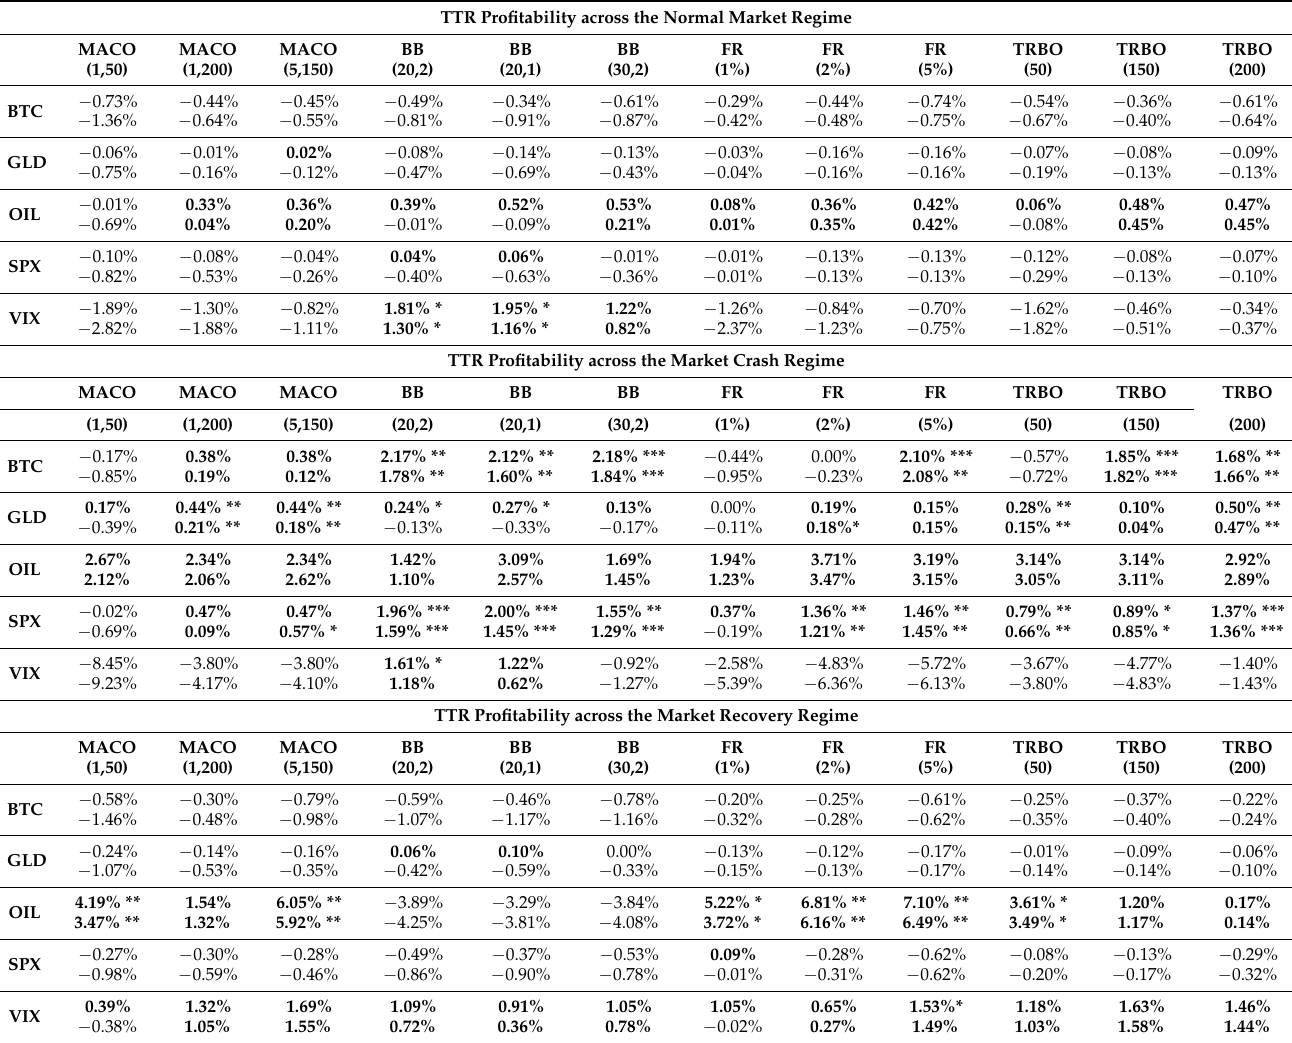
Table A3. TTR Profitability across COVID-19 Market Meltdown Market